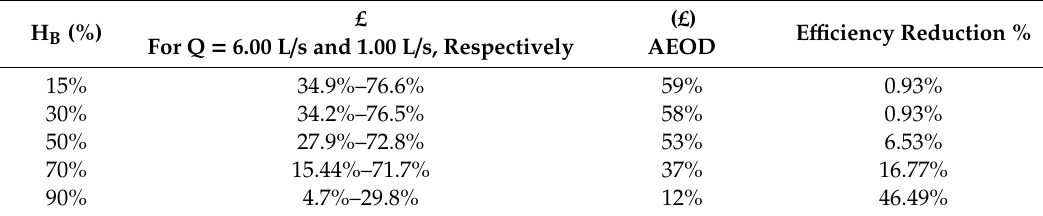
Table 1. The results of e ffi ciency reduction for di ff erent blockage heights.